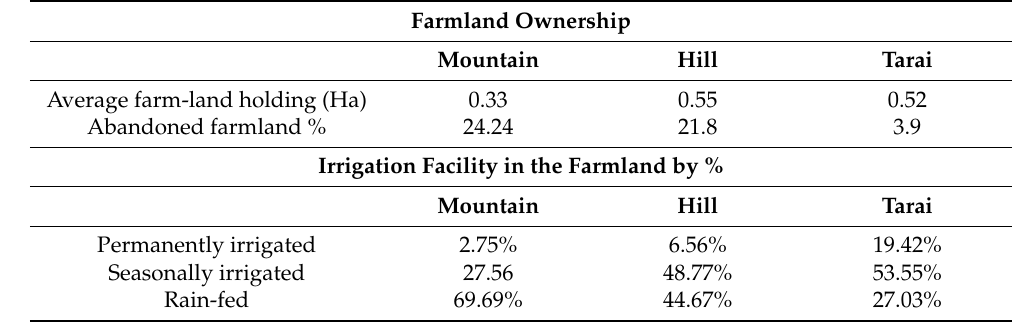
Table 3. Farmland ownership and irrigation